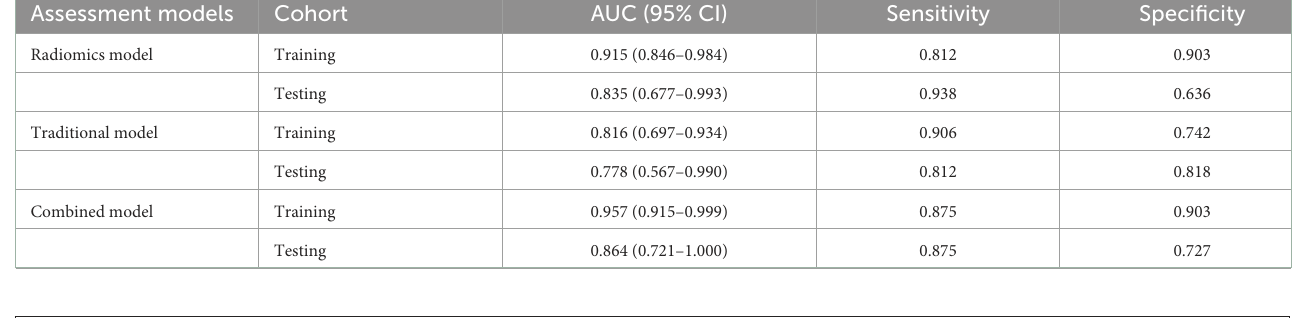
TABLE 2 Performance of the models in training and testing cohorts.